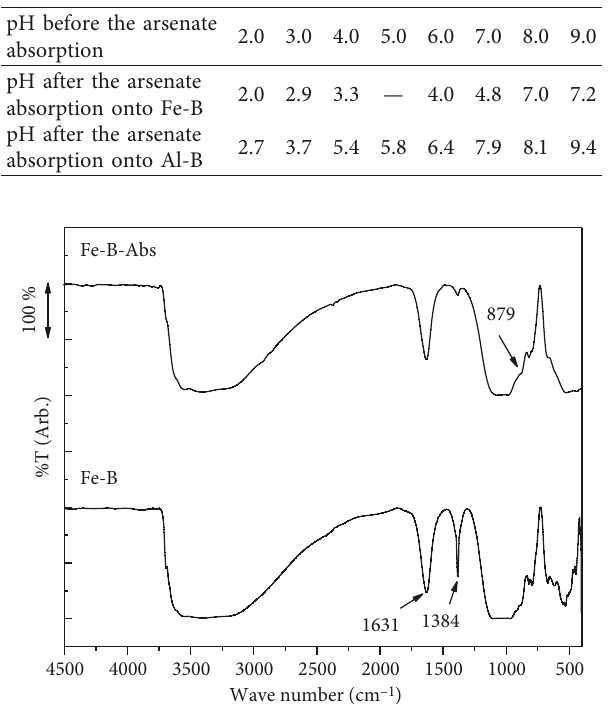
Figure 7: FT-IR spectra of Fe-B before and after the As(V) adsorption.